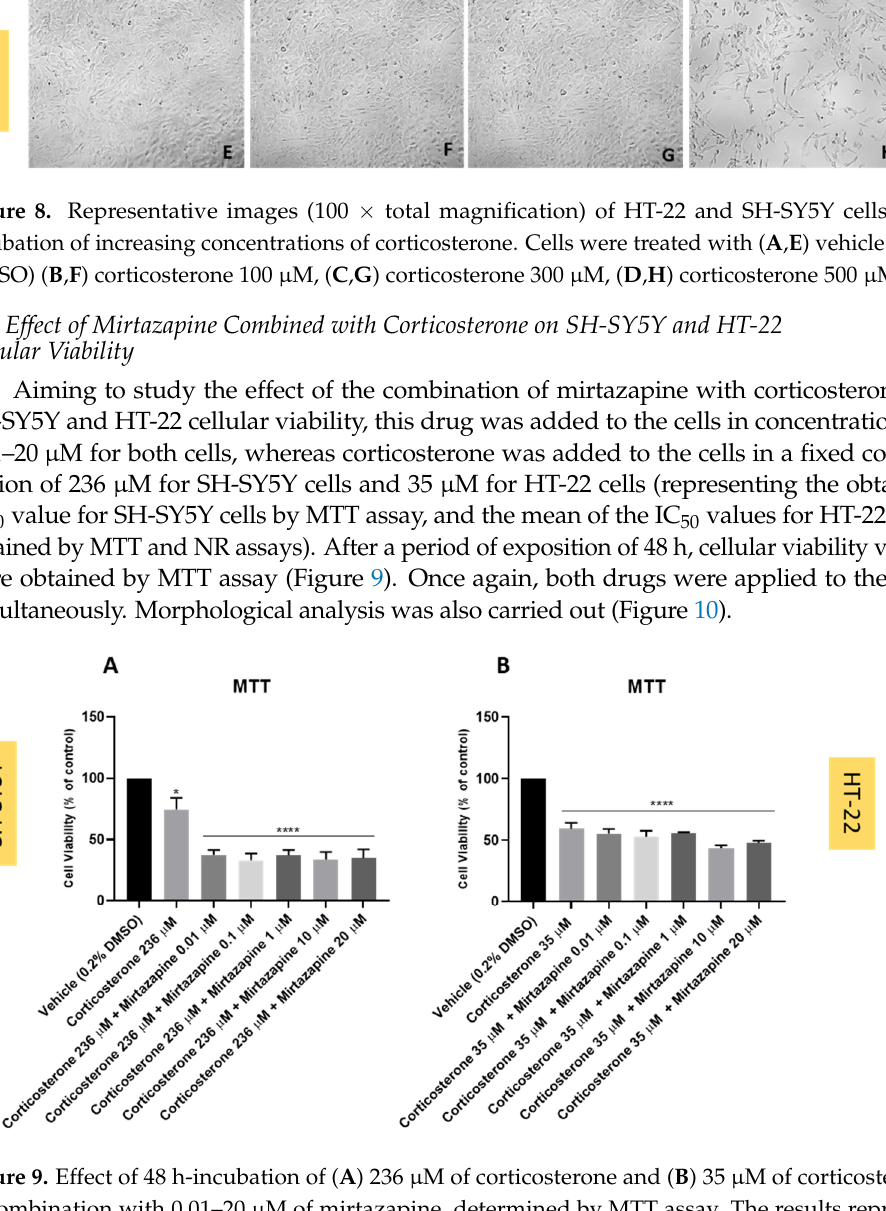
Figure 8. Representative images (100 × total magnification) of HT-22 and SH-SY5Y cells after incu- bation of increasing concentrations of corticosterone. Cells were treated with ( A , E ) vehicle (0.1% DMSO) ( B , F ) corticosterone 100 μ M, ( C , G ) corticosterone 300 μ M, ( D , H ) corticosterone 500 μ M. DMSO) ( B , F ) corticosterone 100 µ M, ( C , G ) corticosterone 300 µ M, ( D , H ) corticosterone 500 µ M.